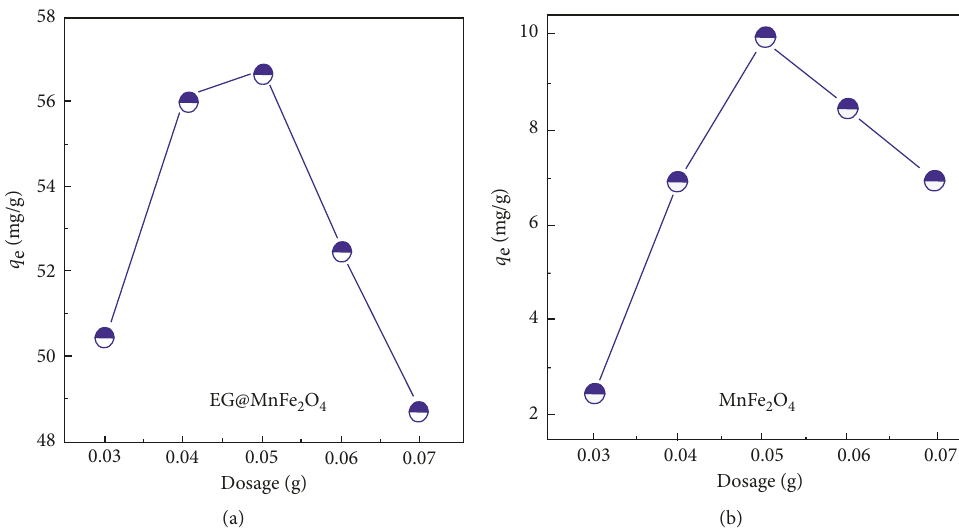
Figure 7: Effect of dosage the adsorption efficiency of CR over the EG@MnFe 2 O 4 (a) and MnFe 2 O 4 (b) materials. Experimental conditions included solution volume of 100mL and dye concentration of 60mg/L at pH 4 for MnFe 2 O 4 and pH 6 for EG@MnFe 2 O 4 . Experiments were run at room temperature (25 ° C) during